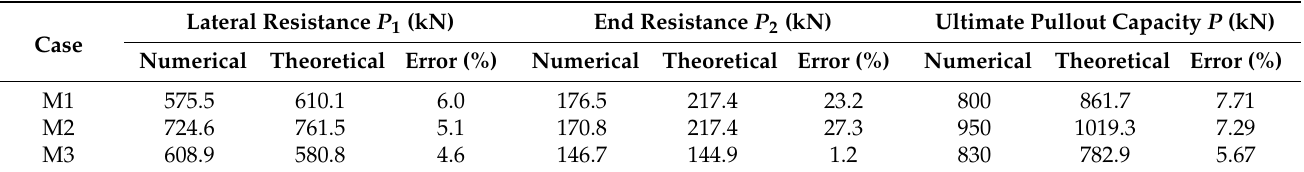
Table 4. Comparison between ultimate pullout capacity according to numerical and theoretical solutions.